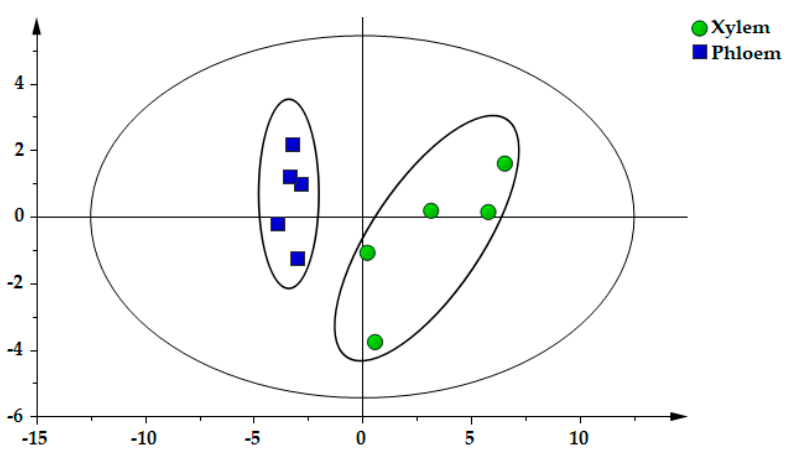
Figure 4. The principal component analysis (PCA) scores scatter plot of xylem and phloem in Spatholobi Caulis (SC).